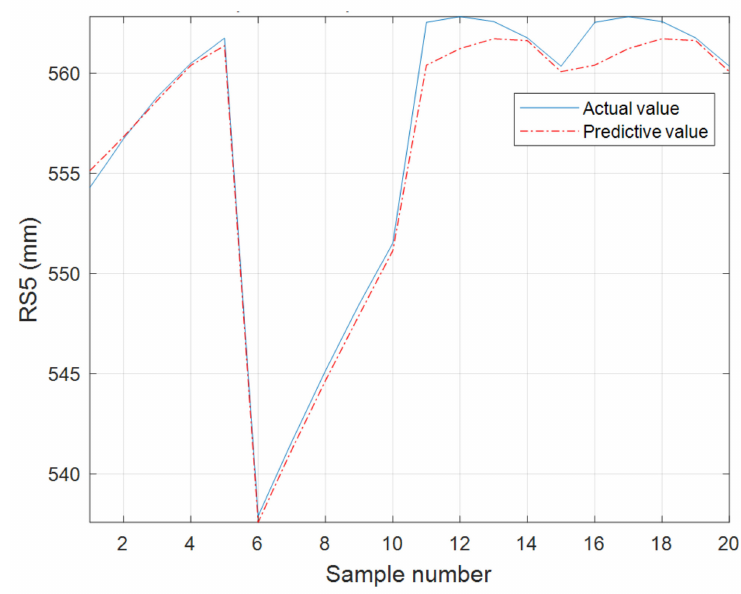
Figure 8. The structure of RNN.